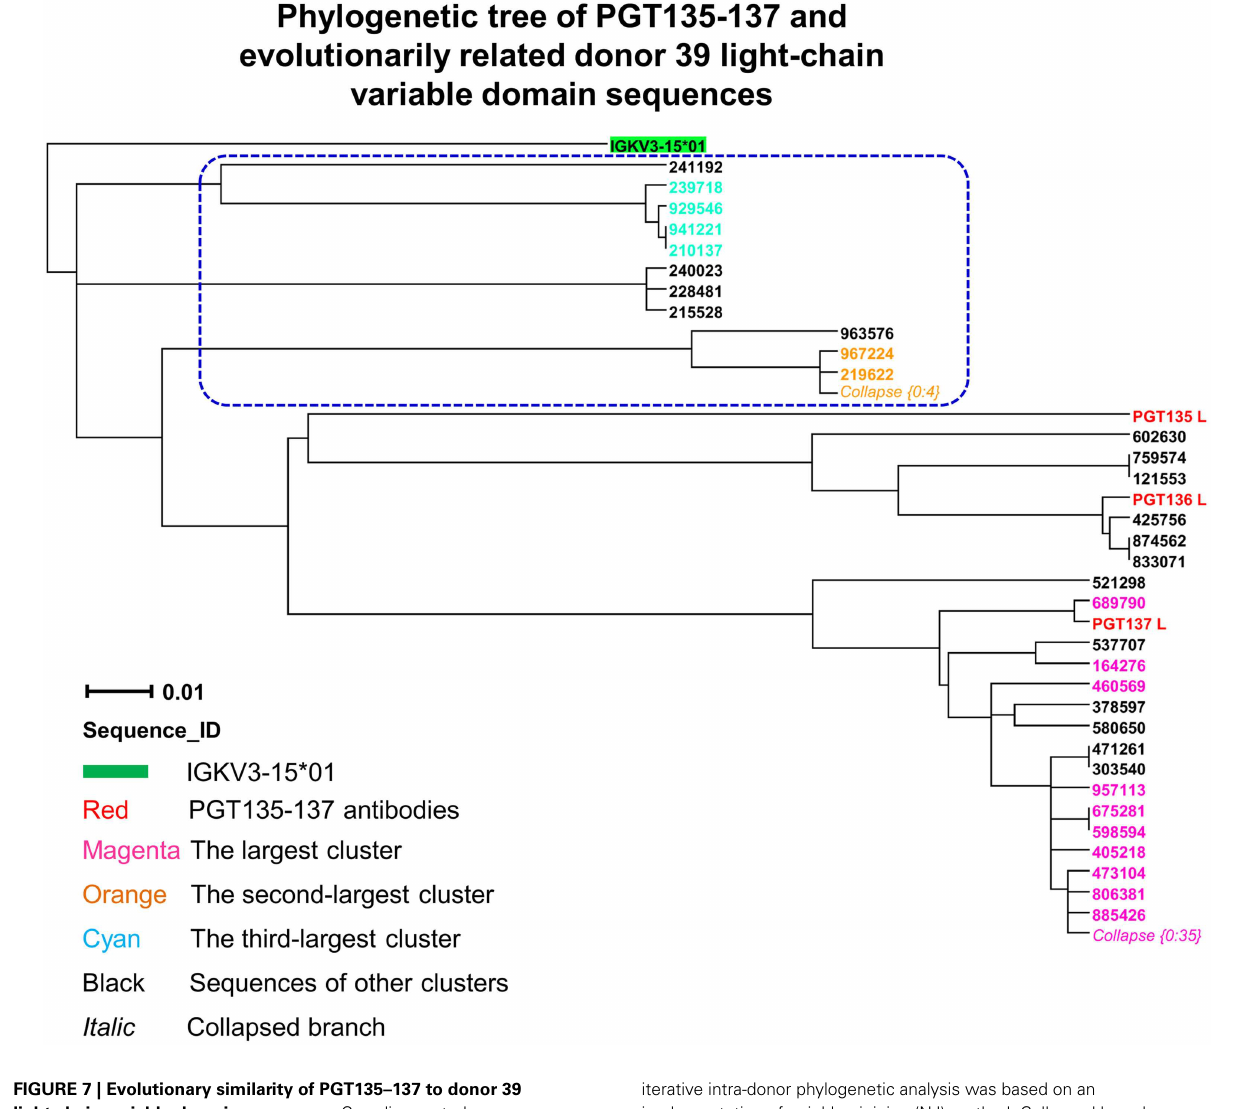
iterative intra-donor phylogenetic analysis was based on an implementation of neighbor-joining (NJ) method. Collapsed branches are indicated by Collapse {N: M} , as in Figure 3 . Sequences that are immediately outside the maximum-likelihood-defined PGT135–137 subtree are circled in blue